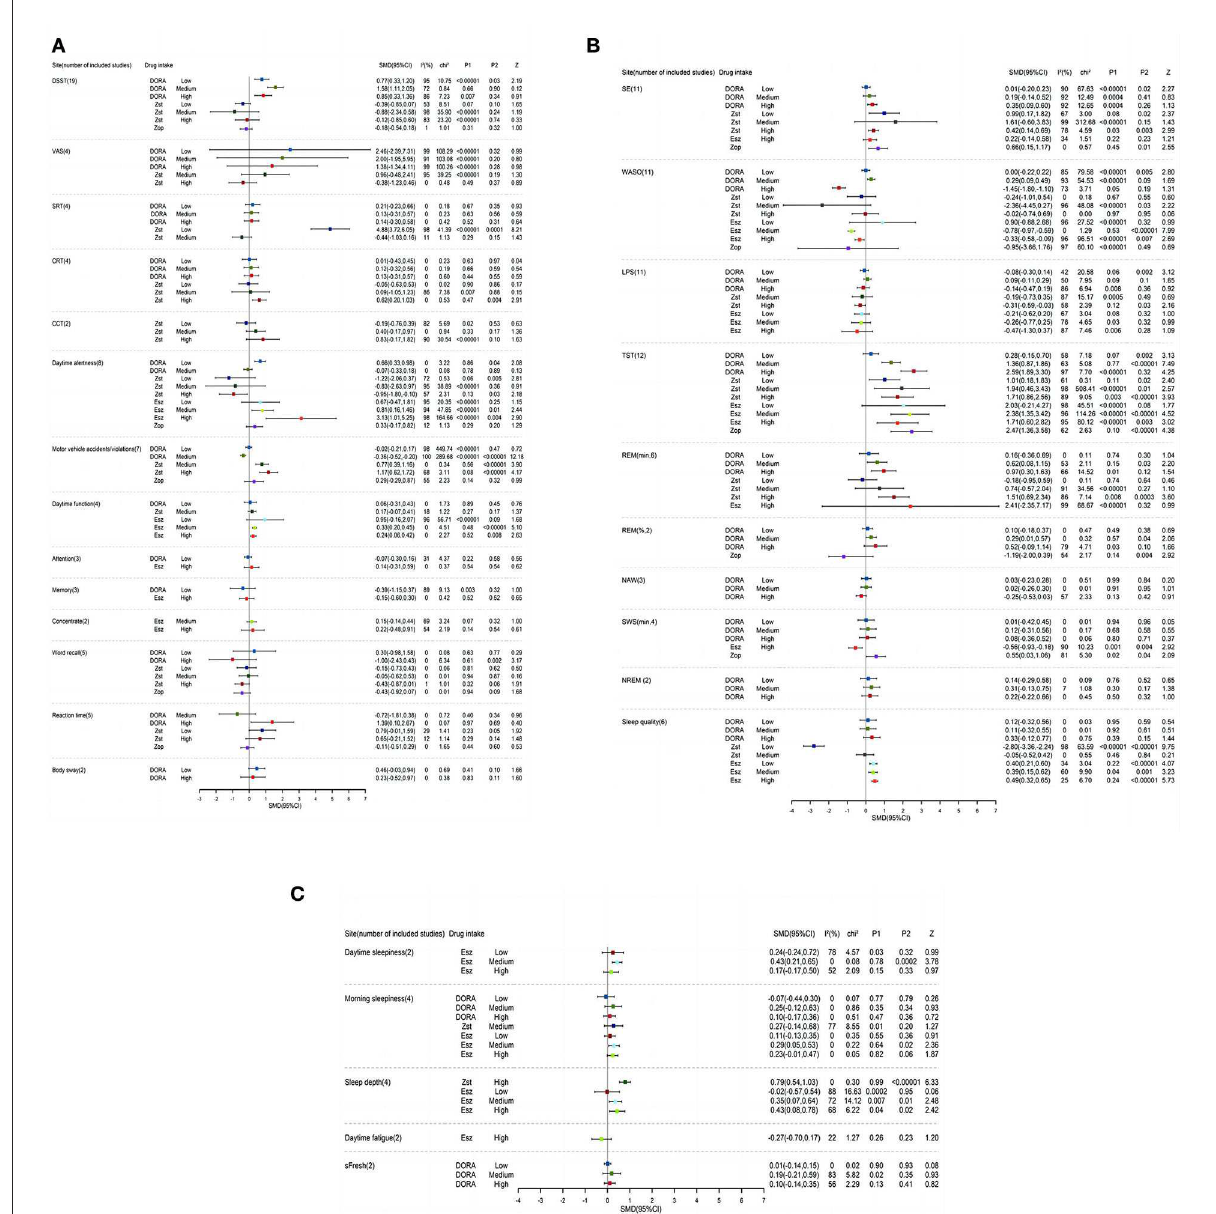
FIGURE2 (A–C) A Forest map of cognition and sleep results at different doses in DORA, zolpidem, zopiclone, and eszopiclone groups. DSST, Digit symbol substitution test; VAS, visual analog scale; SRT, simple response time scale; CCT, competitive cognitive trait anxiety inventory; CRT, competency ratio table; SE, Sleep efficiency; WASO, wake after sleep onset; LPS, latency to persistent sleep; TST, total sleep time; REM, rapid eye movement; NAW, number of awakenings; SWS, slow wave sleep; NREM, non-REM sleep.